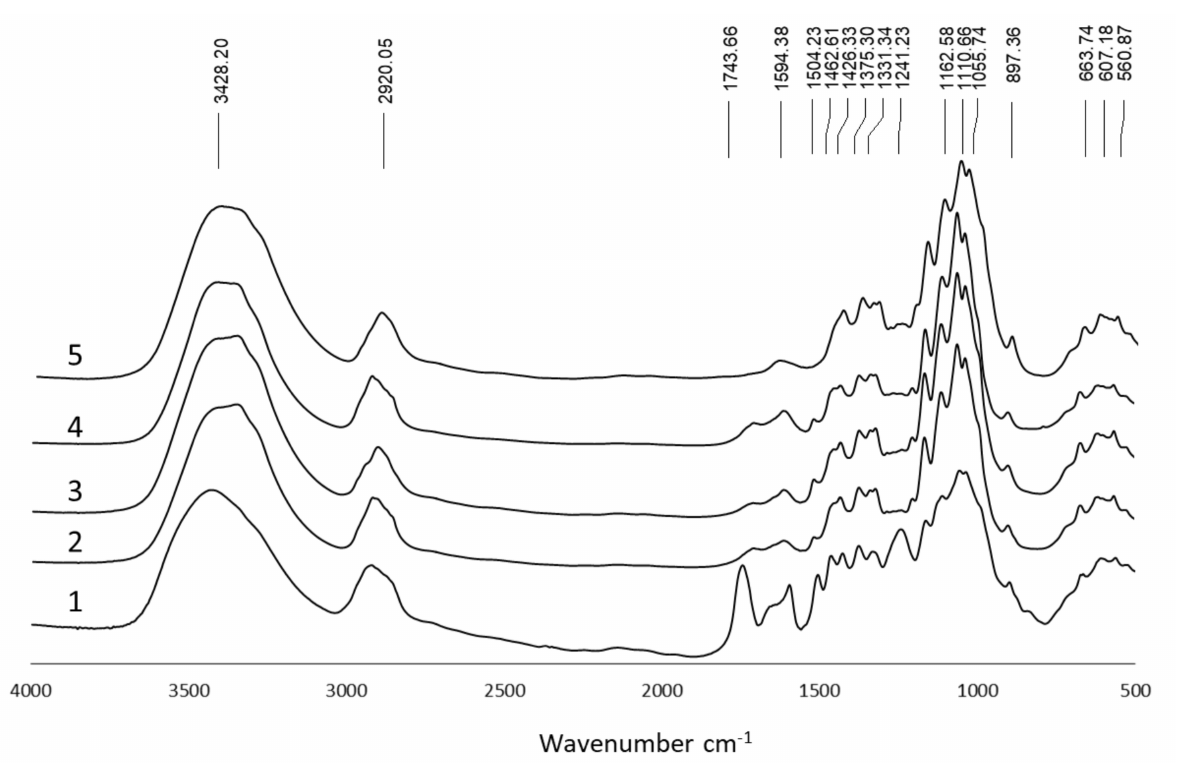
Figure 5. IR spectra of the initial birch wood (1), solid product of non-catalytic hydrogenation of the initial wood (2), solid residue of catalytic hydrogenation of the initial wood (3), solid product of catalytic hydrogenation of the alkali-pretreated wood (4) and solid product of catalytic hydrogenation of the acid-pretreated wood (5). Diffraction patterns of the initial and-pretreated birch wood and of the solid products of their hydrogenation are shown in Figure 6.